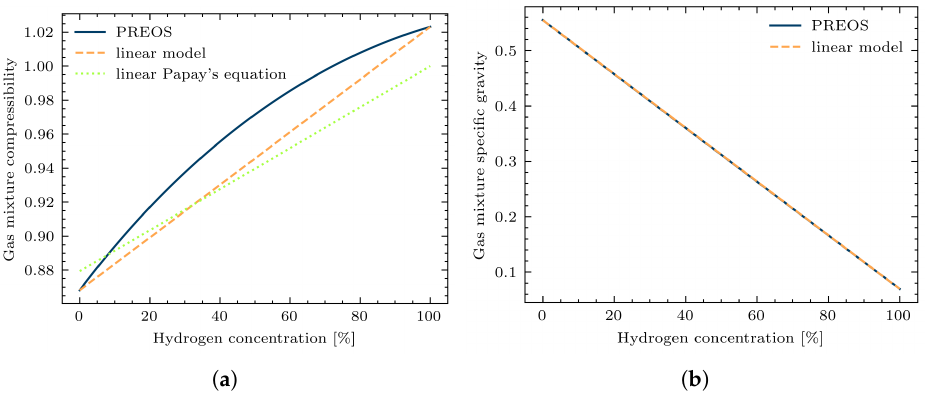
Figure 3. ( a ) Gas mixture compressibility in the relation to the injection of hydrogen. ( b ) Gas mixture specific gravity in relation to the injection of